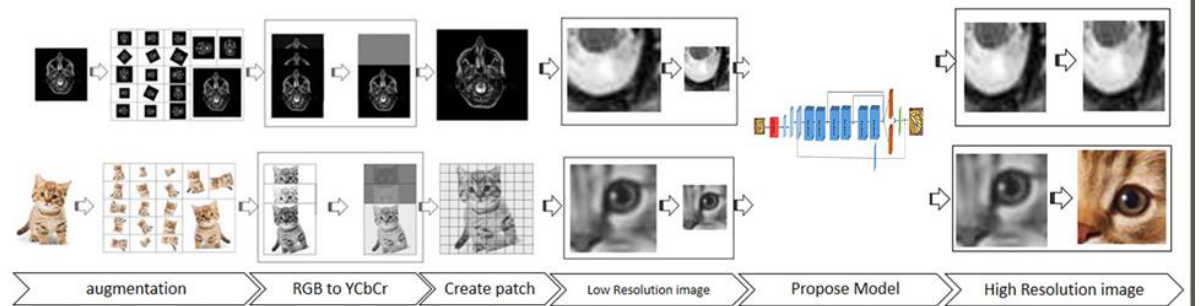
Figure 1. Proposed model for a super-resolution enhancement of an input